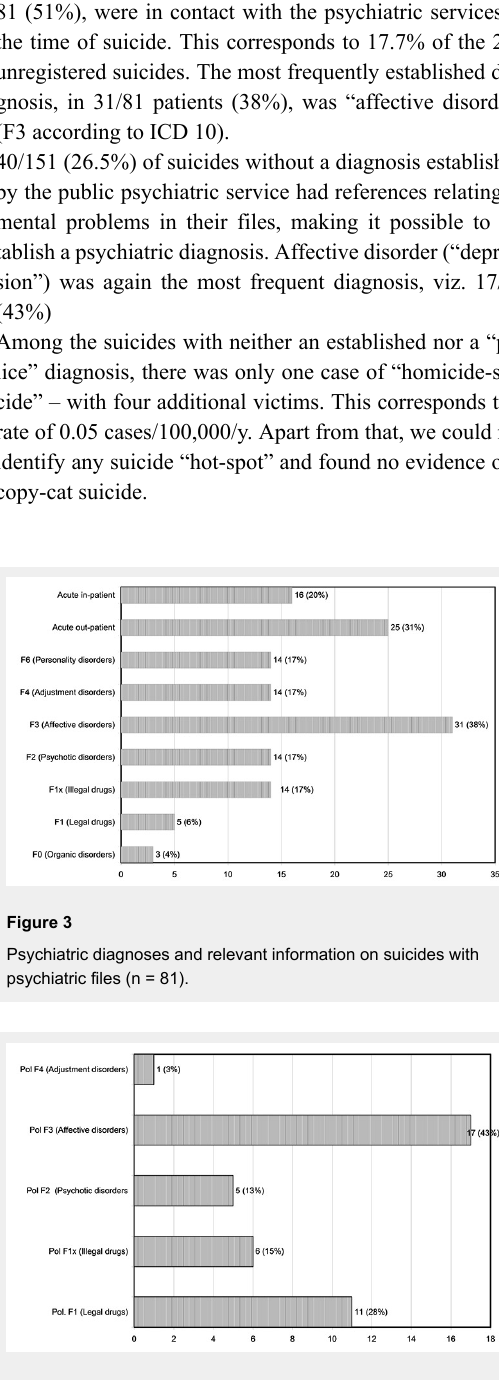
Psychiatric diagnoses from police files (“police diagnosis”, n =